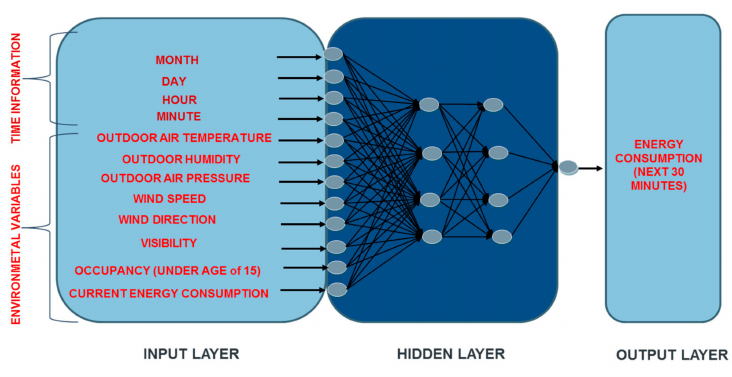
Figure 4. Proposed ANN architecture for each